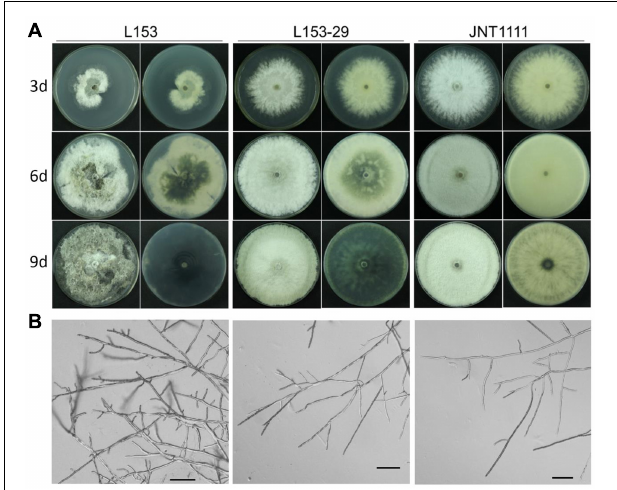
FIGURE 3 | Colony and hyphal characteristics of B. dothidea strains. (A) Colonial morphology of strains L153, L153-29, and JNT1111 growing on potato dextrose agar (PDA) at 25 ◦ C for 3, 6, and 9 days. The front view and rear view were indicated by left and right sides, respectively. (B) Hyphal tips of B. dothidea strains. Scale bar, 100 µ m.